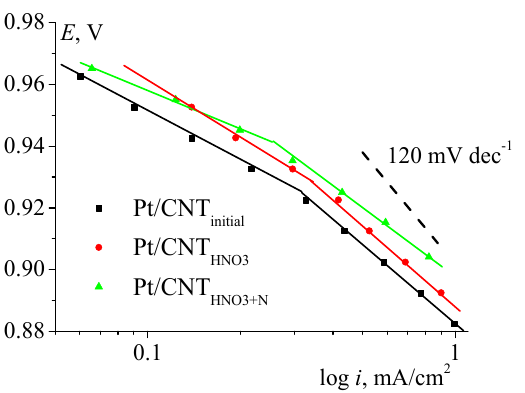
Figure 4. Polarization curves in the Tafels coordinates for platinum-modified materials (indicated in